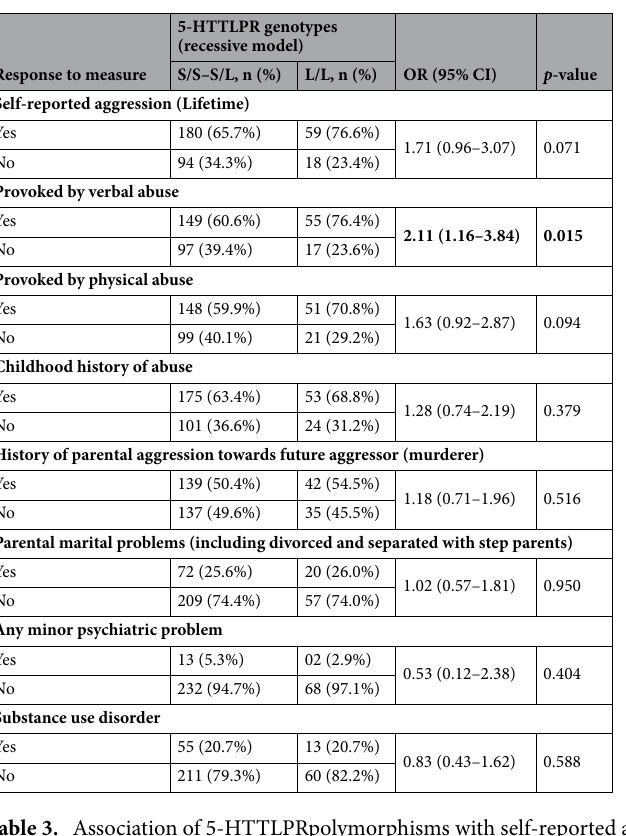
Table 3. Association of 5-HTTLPRpolymorphisms with self-reported aggression, emotional reactivity, related psychopathologies and childhood adversities in sentenced murderers. OR, odds ratio; CI, confidence interval. Boldface indicates p < 0.05 was considered as statistically significant.